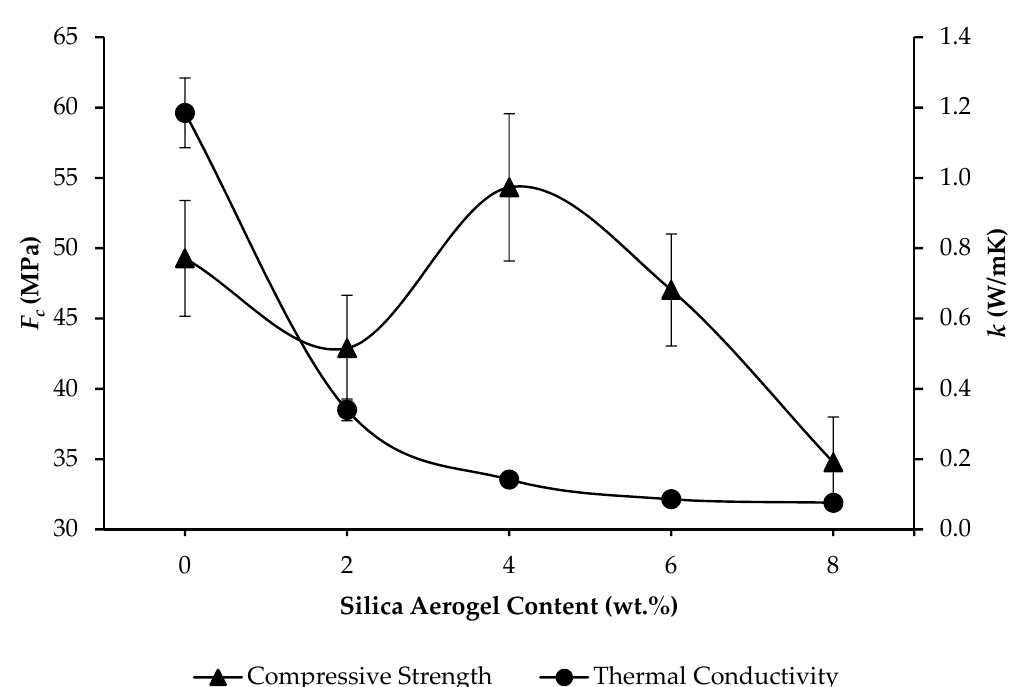
Figure 6. Compressive strength ( F c ) and thermal conductivity ( k ) of the composite cement paste after 28 days of curing.